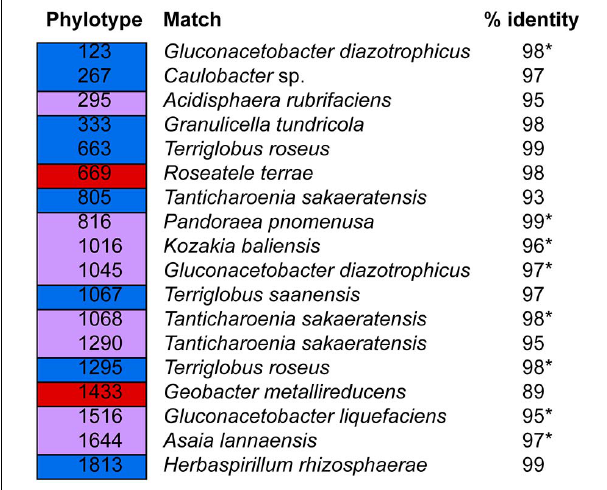
shapes correspond to (A) host species, (B) elevation, and (C) location. (D) Hierarchical clustering of composite communities of the conifer species. Leaves are labeled by color according to host species: red, P. flexilis ; blue, P. engelmannii .